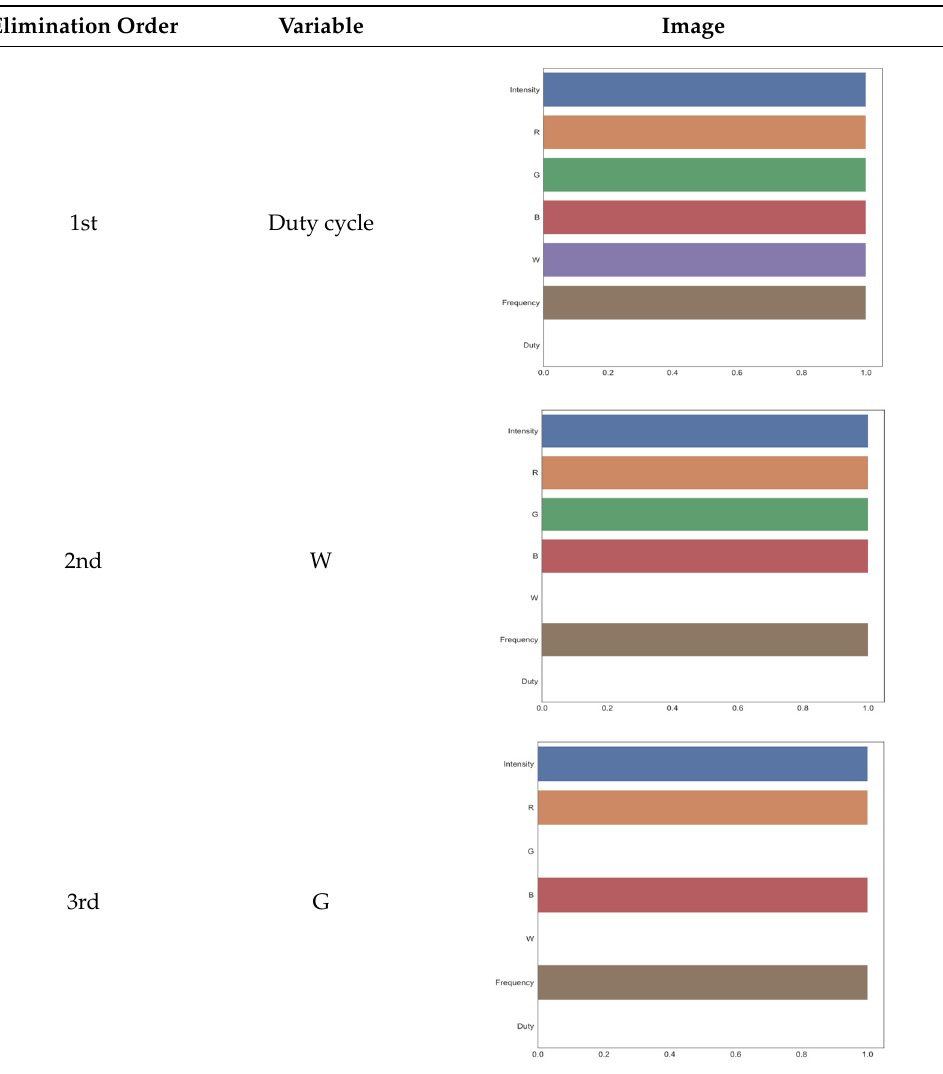
Table 7. Sequential feature deletion from the linear regression.